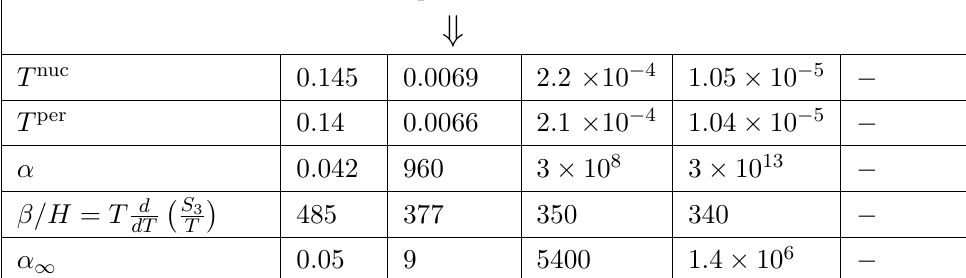
Table 3 . The couplings and the phase transition parameters for the (cid:12)ve reference